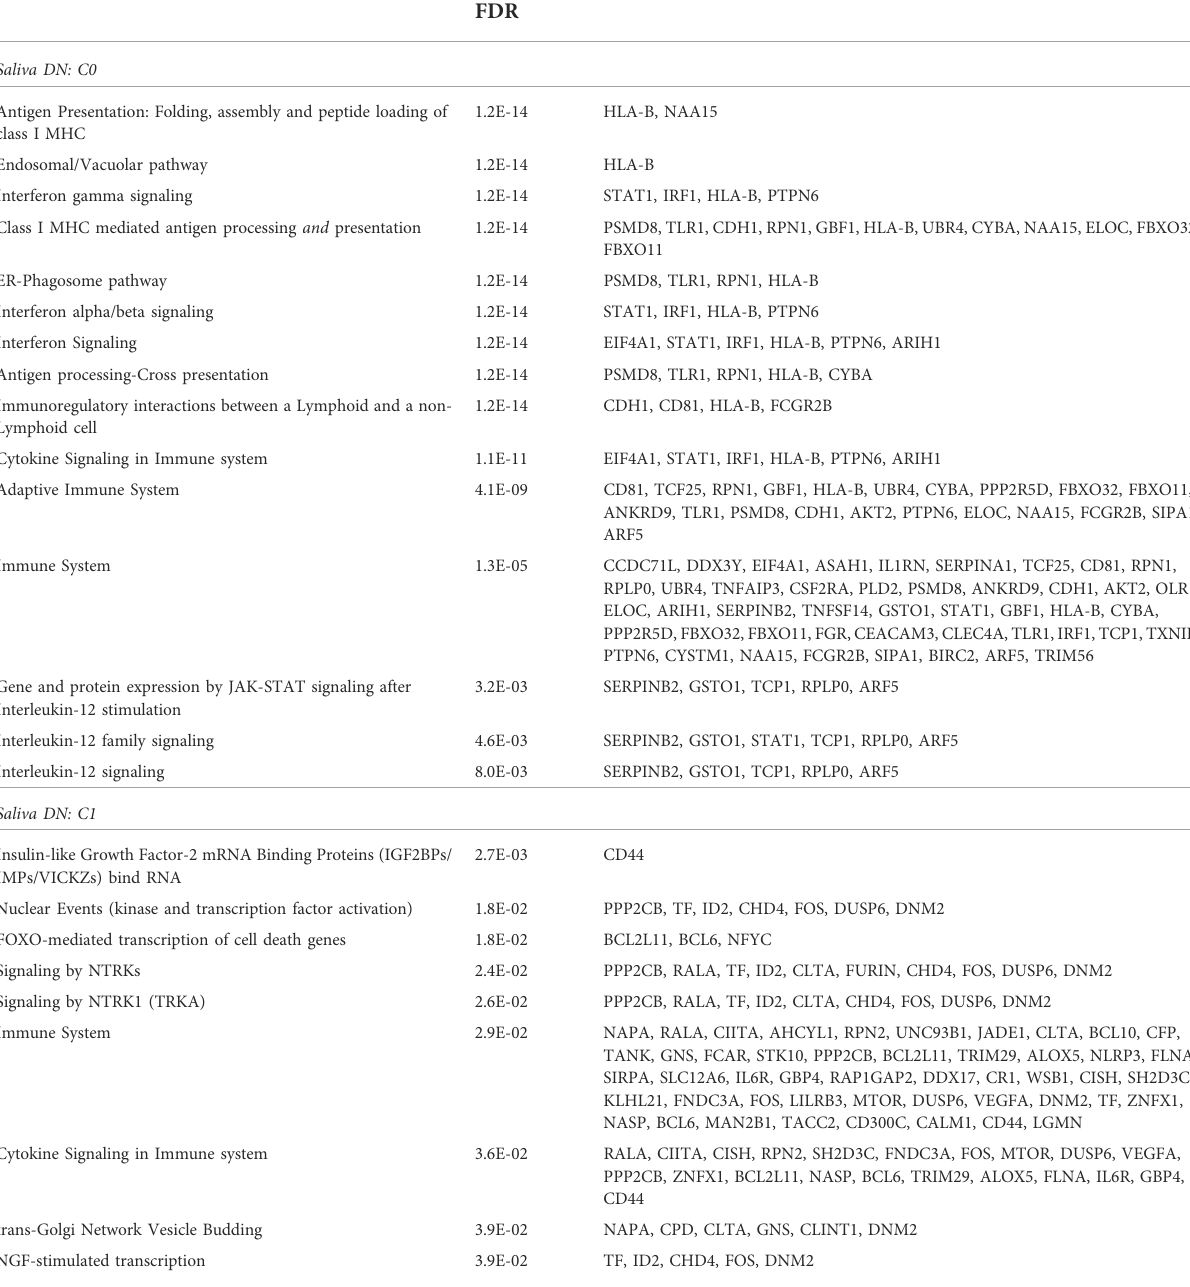
TABLE 1 Reactome pathway enrichment analysis. Statistically signi fi cant pathways (FDR < 0.05) are summarized for saliva DN communities C0 and C1. In the full analysis, we omitted small communities with fewer than 8 genes Reimand et al. (2019); Gene Set Enrichment Analysis (2022), and 12 communities (C0 to C11) quali fi ed for the pathway